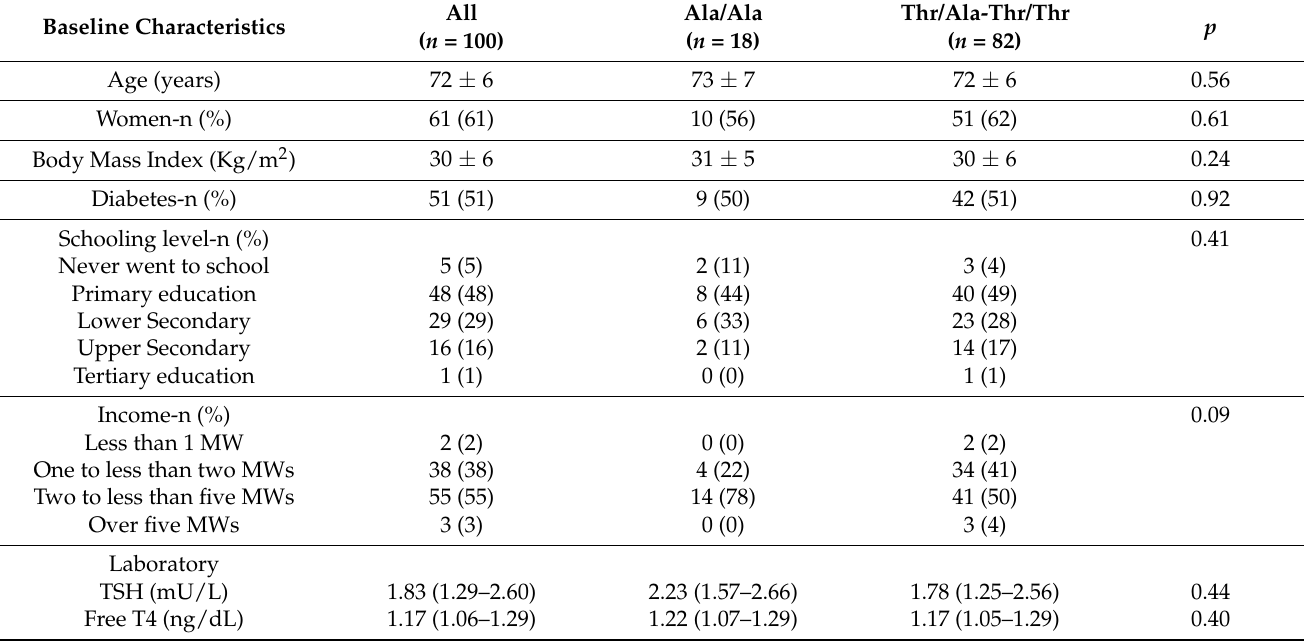
Table 1. Clinical and laboratory characteristics of patients grouped according to Type 2 Deiodinase Thr92Ala